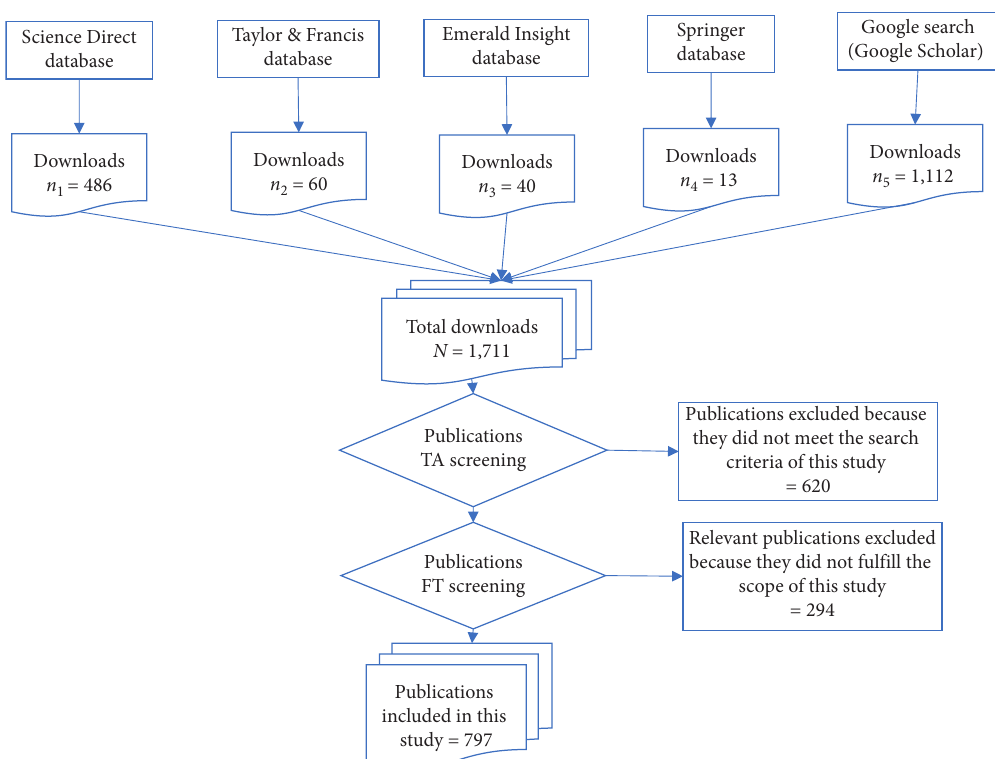
Figure 2: The flowchart diagram for the literature search strategy used in this study. N � n of PDF files downloaded from the respective